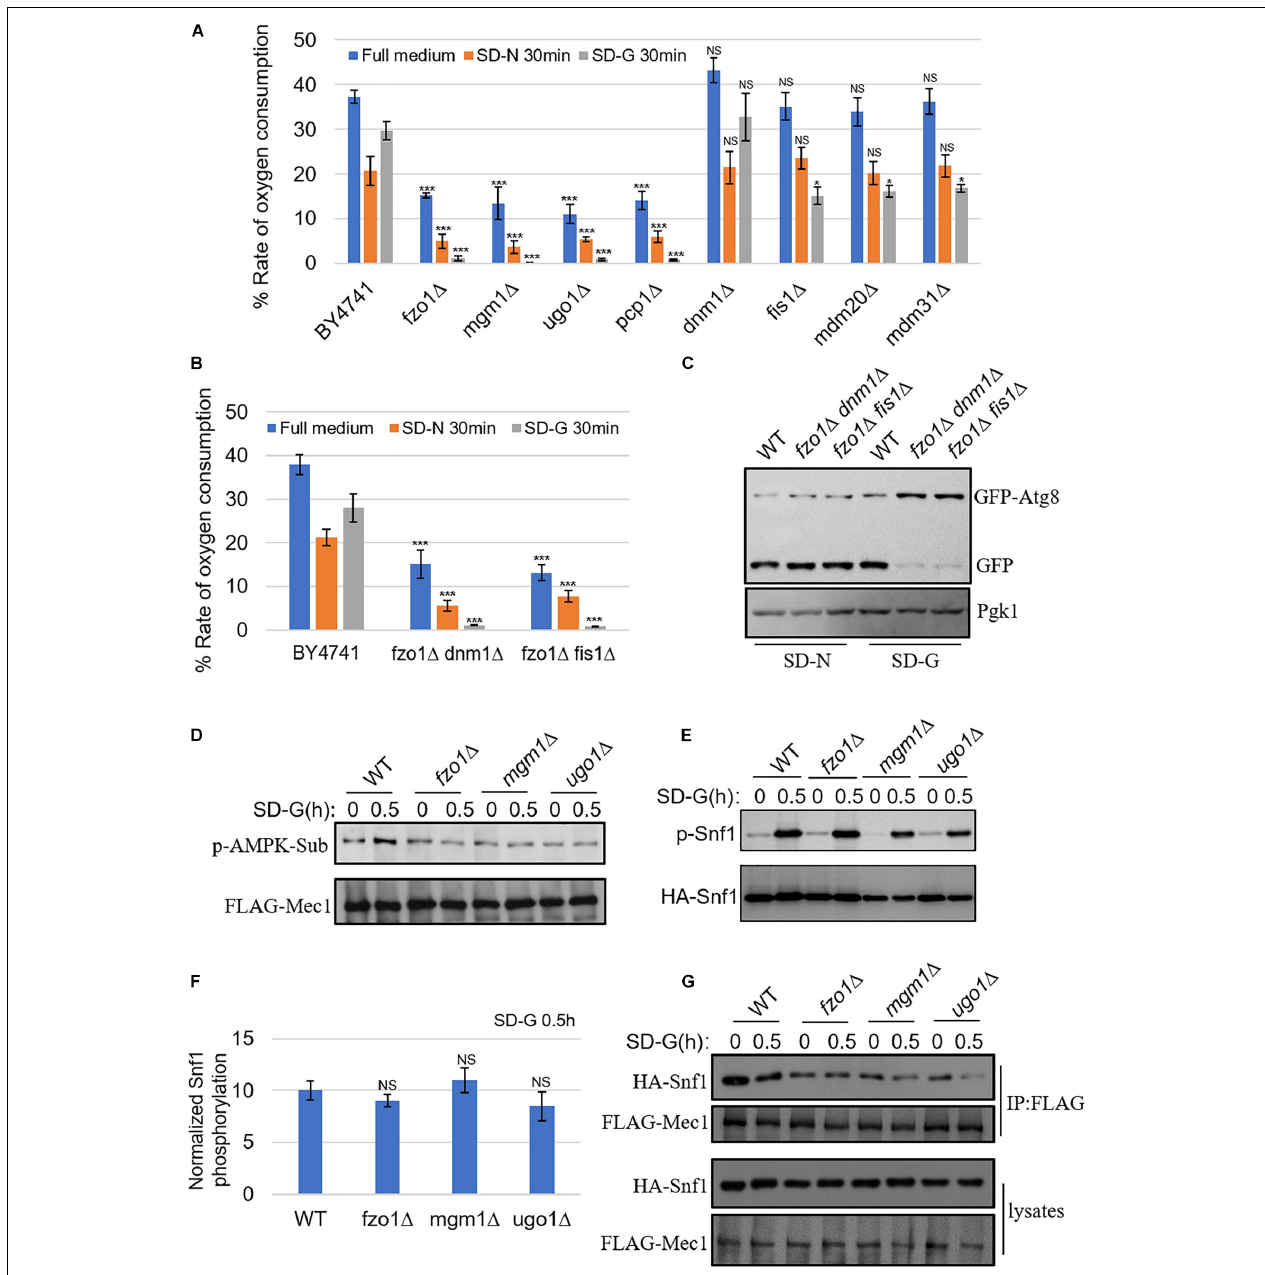
FIGURE 3 | Mitochondrial fusion machinery regulates aerobic respiration of mitochondria and the association of Mec1 with Snf1 upon glucose starvation. (A) WT (BY4741), fzo1 (cid:49) , mgm1 (cid:49) , ugo1 (cid:49) , pcp1 (cid:49) , dnm1 (cid:49) , fis1 (cid:49) , mdm20 (cid:49) , and mdm31 (cid:49) strains were cultured in SD-N or SD-G for 0 and 30 min. Cells were harvested and oxygen consumption was measured using O2K. n = 3 independent experiments were quantified. Data are presented as means ± SD. *** p < 0.001; * p < 0.05; NS, not significant; two-tailed Student’s t -tests were used. (B) WT (BY4741), fzo1 (cid:49) dnm1 (cid:49) , and fzo1 (cid:49) fis1 (cid:49) strains were starved in SD-N or SD-G for 0 and 30 min. Cells were harvested and oxygen consumption rate was measured using O2K. n = 3 independent experiments were quantified. Data are presented as means ± SD. *** p < 0.001; two-tailed Student’s t -tests were used. (C) GFP-Atg8 plasmids were expressed in WT (BY4741), fzo1 (cid:49) dnm1 (cid:49) , and fzo1 (cid:49) fis1 (cid:49) strains. Cells were subjected to SD-G or SD-N for 4 h. Autophagic activity was detected by western blot using anti-GFP antibody. (D) FLAG-Mec1 was expressed in the yeast strains listed from Wild type (WT), fzo1 (cid:49) , mgm1 (cid:49) and ugo1 (cid:49) . Yeast cells were grown to the log-growth phase, then subjected to glucose starvation (SD-G) for 0 and 0.5 h. Phosphorylation of immunoprecipitated FLAG-Mec1 was detected by immunoblotting with phospho-(Ser/Thr) AMPK substrate antibody. (E) HA-Snf1 was expressed in Wild type (WT), fzo1 (cid:49) , mgm1 (cid:49) , and ugo1 (cid:49) yeast strains. Yeast cells were cultured in glucose starvation (SD-G) for 0 and 0.5 h. The kinase activity of Snf1 was detected by immunoblotting with anti-p-PRKAA/AMPK α (Thr172) antibody. (F) Quantification of the ratio of p-Snf1/HA-Snf1 from (E) by ImageJ software. NS, not significant; two-tailed Student’s t -tests were used. (G) FLAG-Mec1 and HA-Snf1 were co-expressed in Wild type (WT), fzo1 (cid:49) , mgm1 (cid:49) and ugo1 (cid:49) yeast strains. Yeast cells were cultured in glucose starvation (SD-G) for 0 and 0.5 h. Cell lysates were immunoprecipitated with anti-FLAG agarose beads and then analyzed by western blot using the indicated antibody.